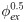
Conformational dynamics of CLD N-lobeapo.(A) K-means (k = 4) cluster analysis of exchange rates for CLD N-lobeapo. The mean values of the clusters are 6900 s-1 (n = 8; red), 15400 s-1 (n = 20; green), 30800 s-1 (n = 8; blue) and 57100 s-1 (n = 3; violet). The black line represents the sum of the four clusters. The inset shows the structure of CLD N-lobeapo (colored as in Fig 3) with exchanging amide protons as spheres, color coded according to cluster identity. (B) Correlation between ϕex0.5 and magnitude of differences between observed chemical shifts and expected chemical shifts for a random coil.